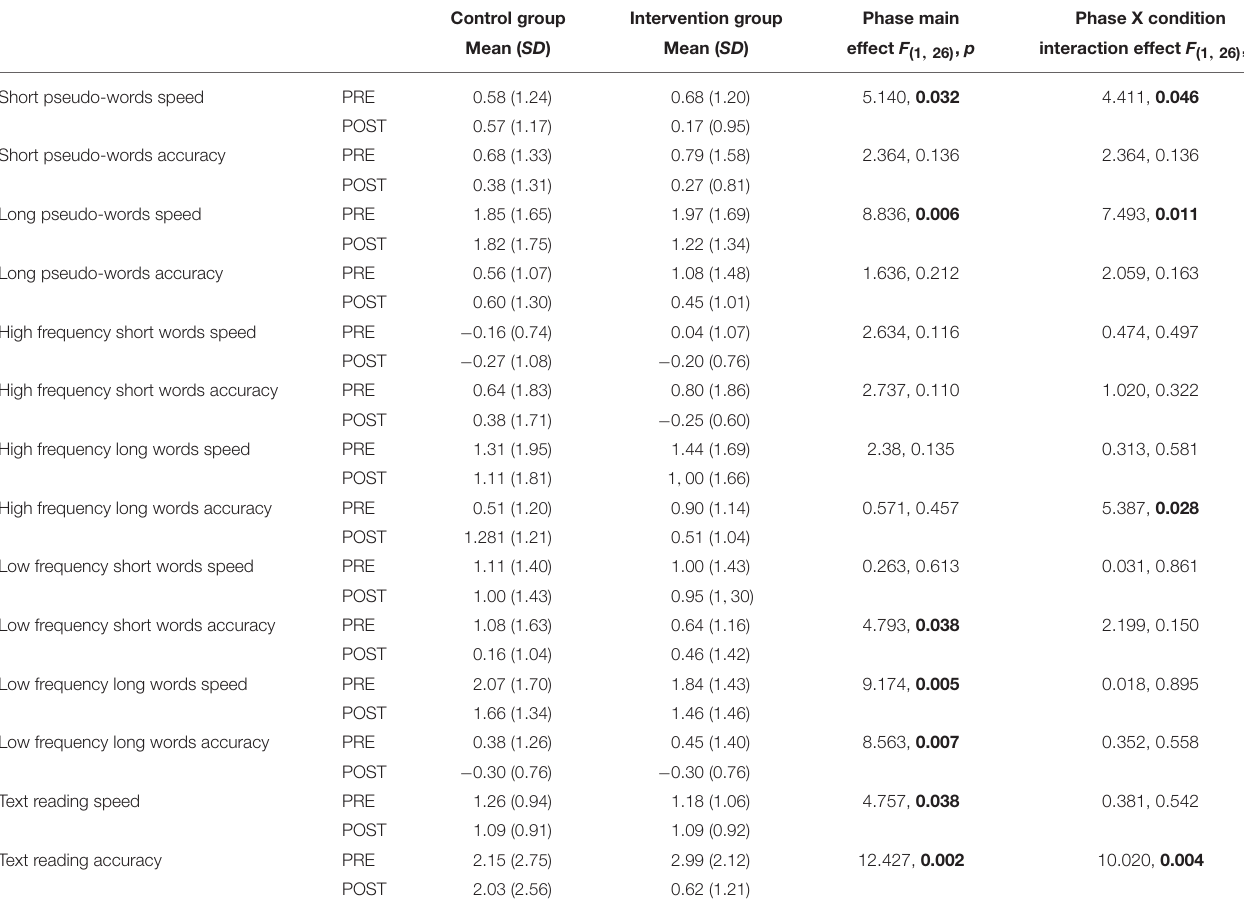
TABLE 2 | Mean z-scores (SD in parentheses) and ANOVA results for words, pseudo-words and text reading speed, and accuracy tasks ( p -values indicating significant effects are marked in